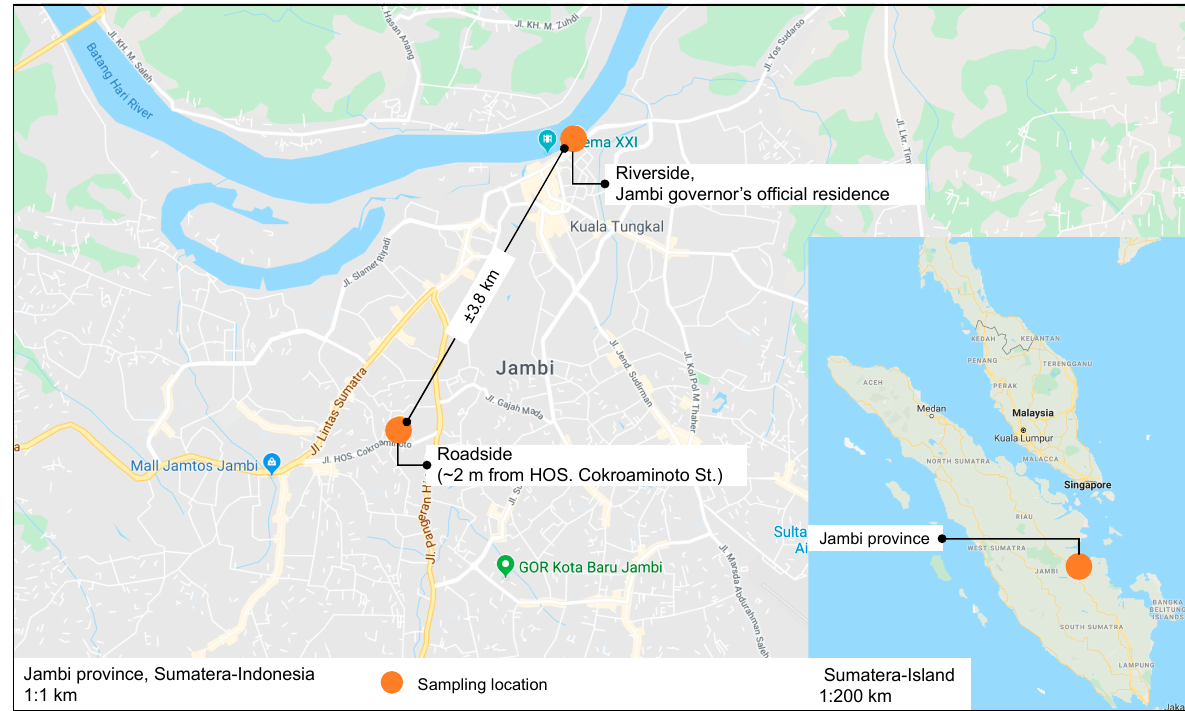
Figure 1. Sampling site at the roadside and riverside in Jambi City, Indonesia.